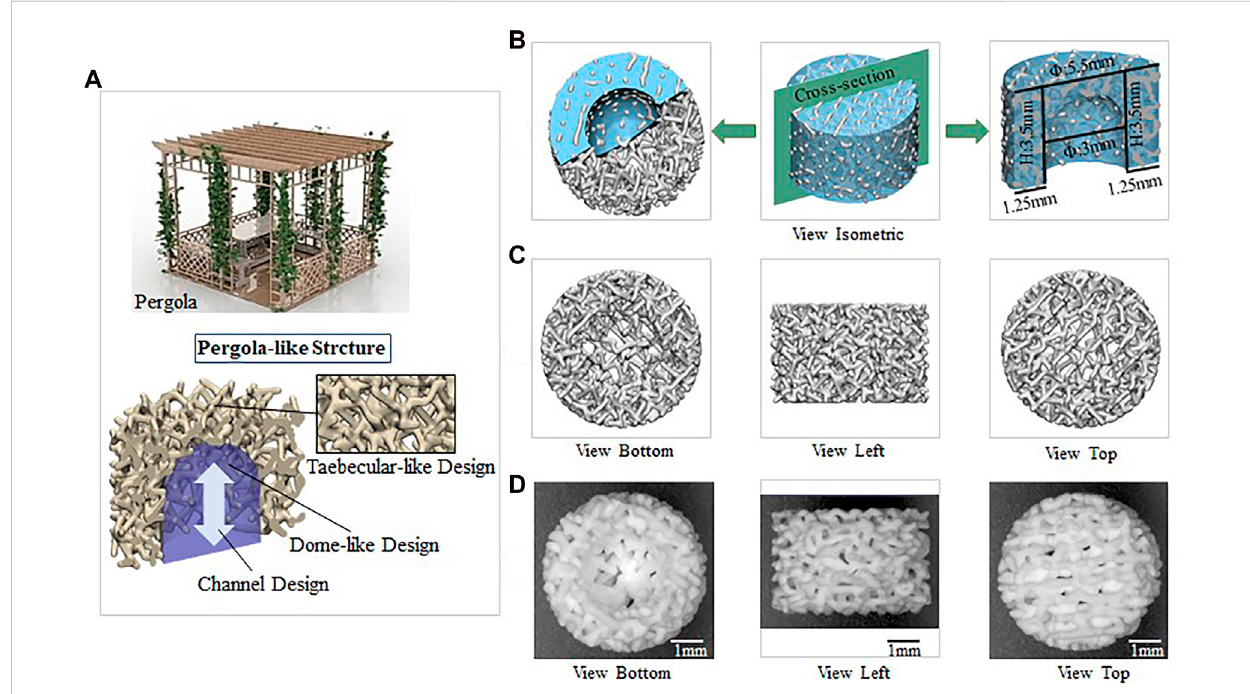
FIGURE 1 Biomechanically stable pergola-like additively manufactured scaffold with 84.65% porosity (A) The microscopic images of the P84.65% scaffold on top and longitudinal sections (B) Schematic diagram of P84.65% scaffold (Blue: Outline drawing of scaffold foundation/Green: Cross-section/Grey: scaffold) (C) The design images of P84.65% scaffold (D) The 3D-printed images of P84.65%